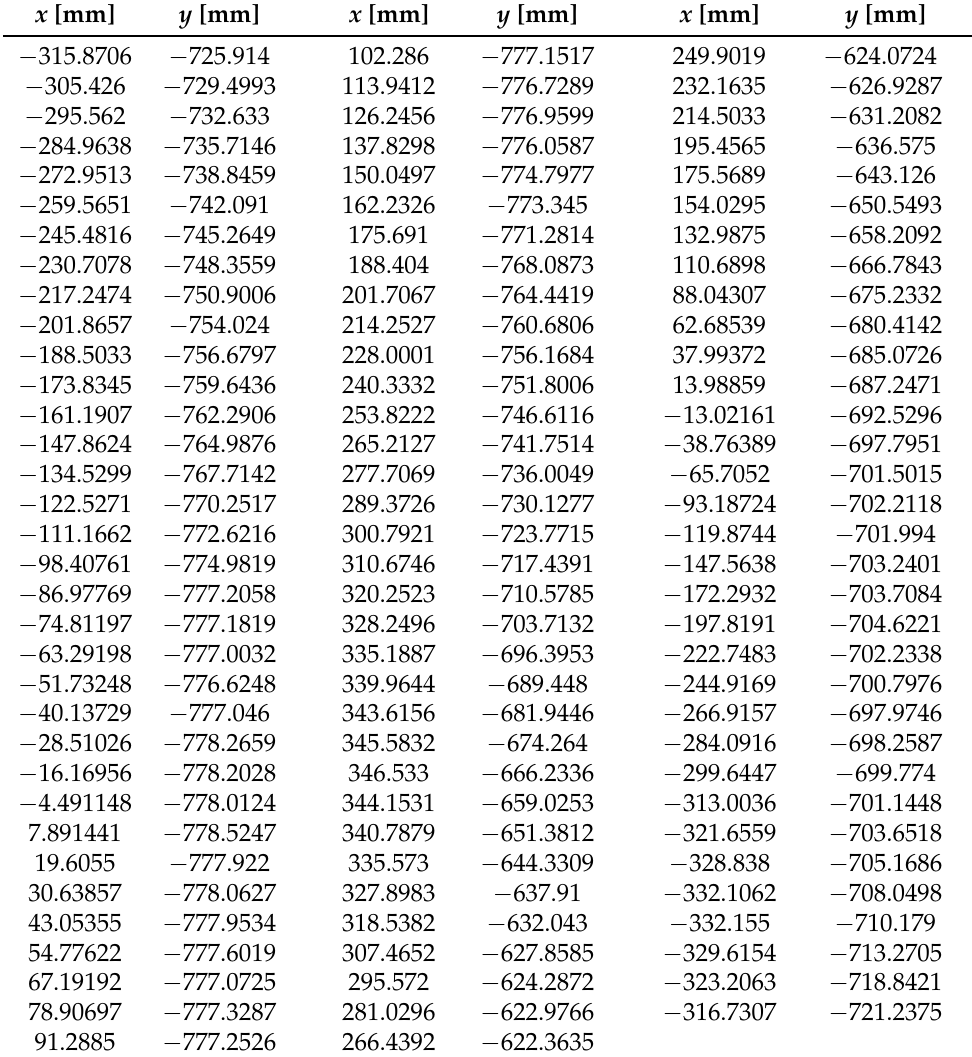
Table A3. Cartesian coordiantes of the precision points for trajectory 2 in study case